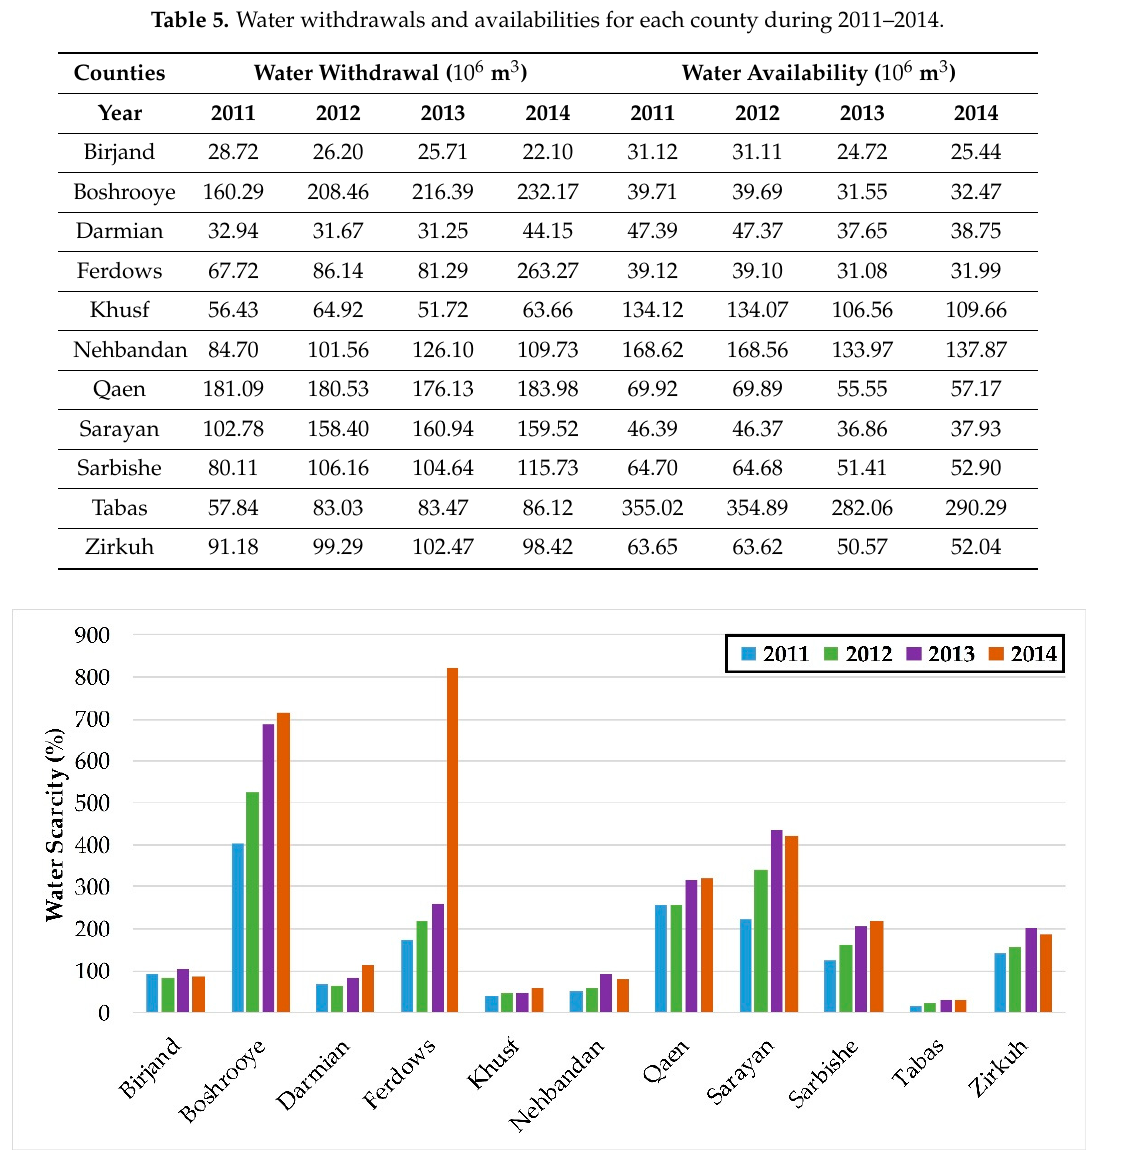
Figure 8. Temporal variability of the water scarcity (WS) in all counties from 2011 to 2014.